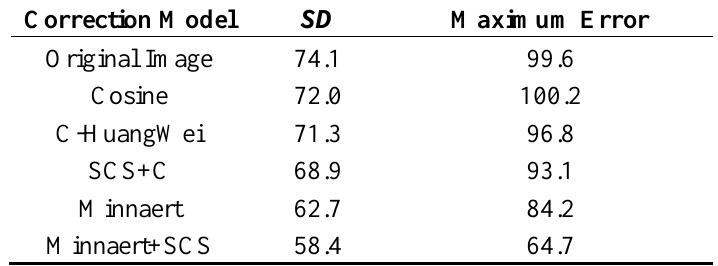
Table 8. The statistics result of actual biomass and the estimation in comparison (g/m 2